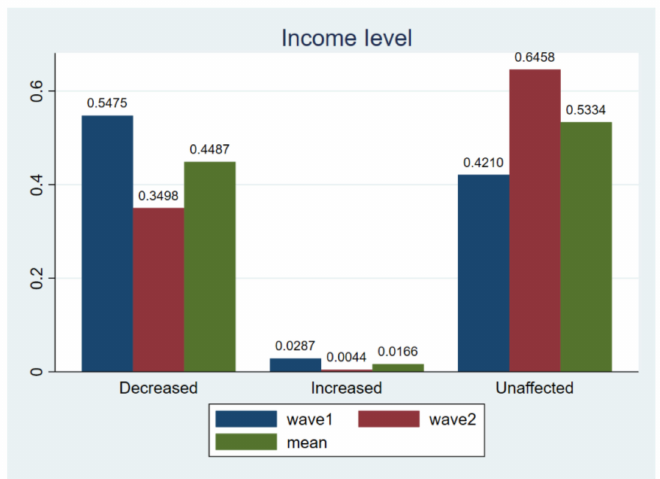
Figure 2. Comparing income level. Notes: t -test for H 0 : equal variance assumed: t value = 8.5551, Pr (|T| > |t|) = 0.0000; wave1 vs.